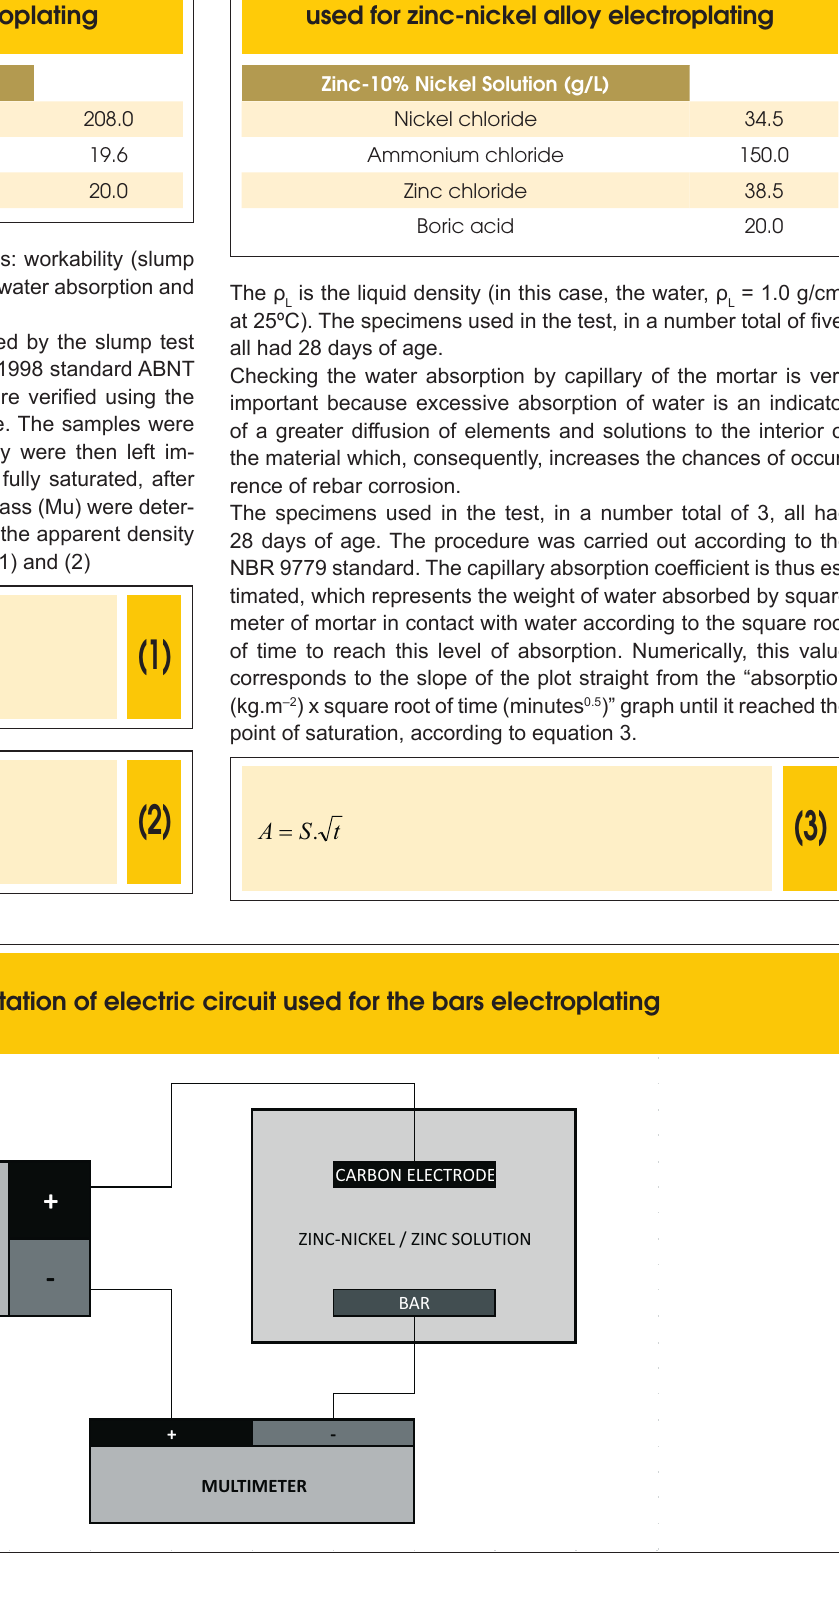
Table 4 – Composition of the electrolyte Table 5 – Composition of the electrolyte solution